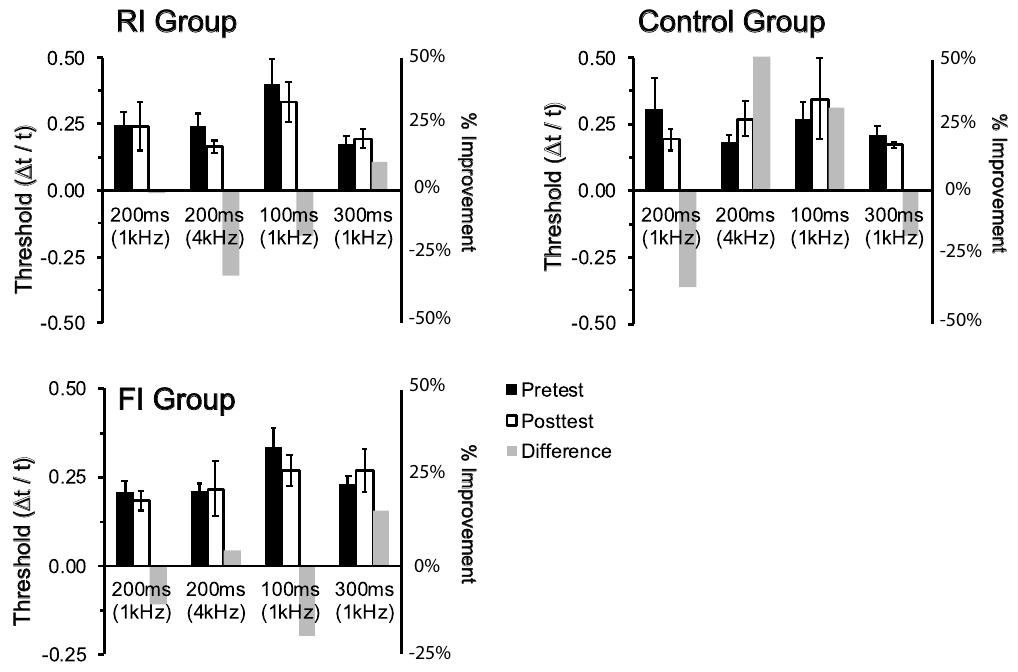
Figure 3. Discrimination thresholds (left) and percent improvement (right) for the untrained temporal comparison task. We did not observe a significant learning effect for the trained 200 ms interval between pretest and posttest sessions. Error bars represent ±